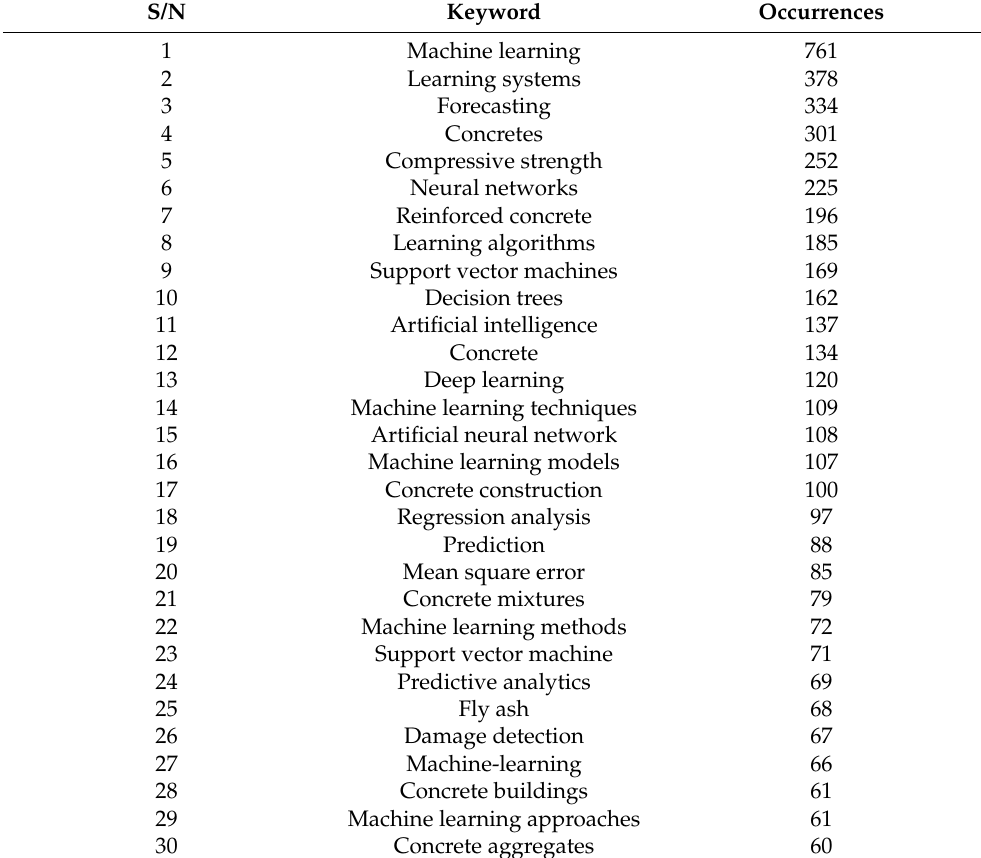
Table 2. List of the 30 most commonly used keywords in the studies of ML applications for concrete. S/N Keyword Occurrences